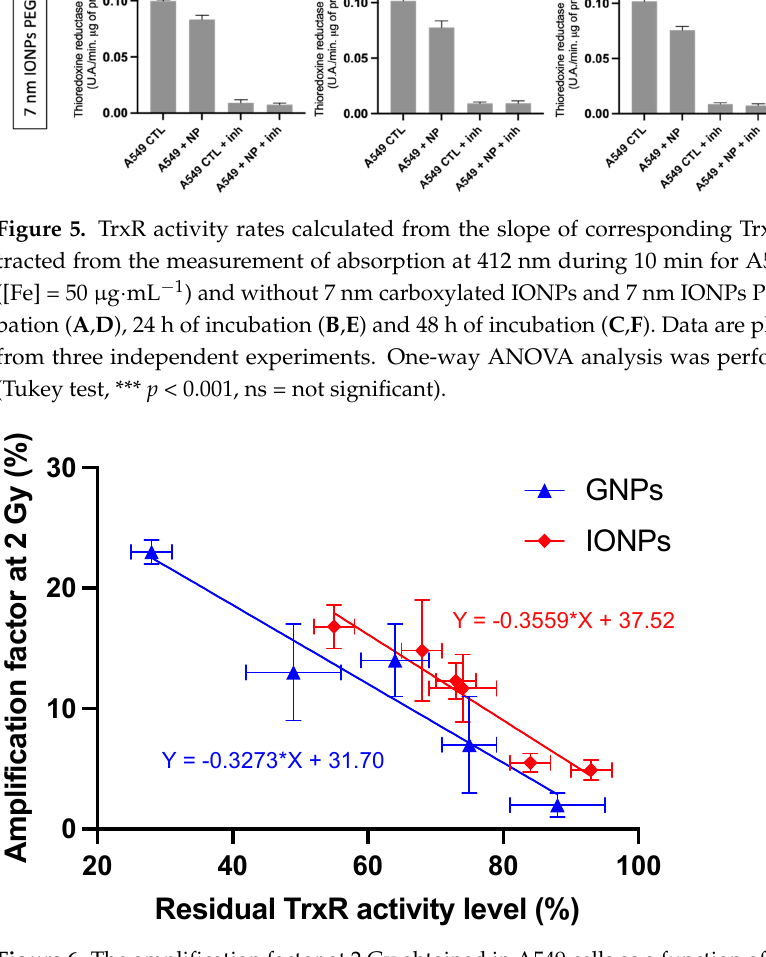
Figure 6. The amplification factor at 2 Gy obtained in A549 cells as a function of residual TrxR activity. Gold data (blue) reported by Penninckx et al. [38] showed the influence of 10 nm amino-PEG GNPs on five different cell lines, while IONP data (red) showed the influence of two IONPs on A549 cells over time. Data are plotted as means ± SD from three independent experiments. Pearson’s correlation analysis was carried out for the scatterplot (r = −0.913).